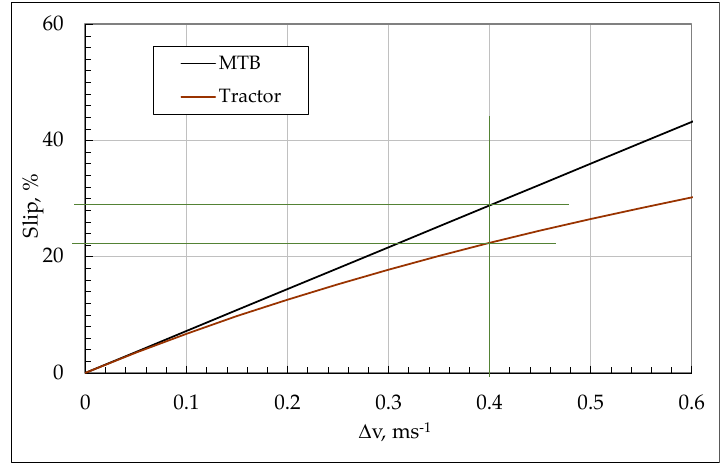
Figure 8. Slip values in the MTB tires, s MTB , and in the 2WD tractor rear tires, s T , as a function of the relative speed between tire and soil. The diagram refers to the test speed of 1.39 m ∙ s − 1 , but a similar behaviour can be observed for each speed.